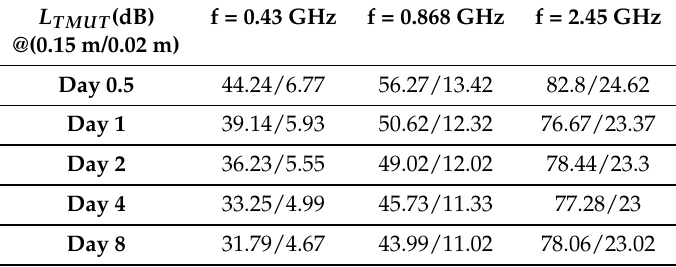
Table 4. Concrete propagation parameters for d MUT = 0.15 m and 0.02 m at 0.43 GHz, 0.868 GHz, and 2.45